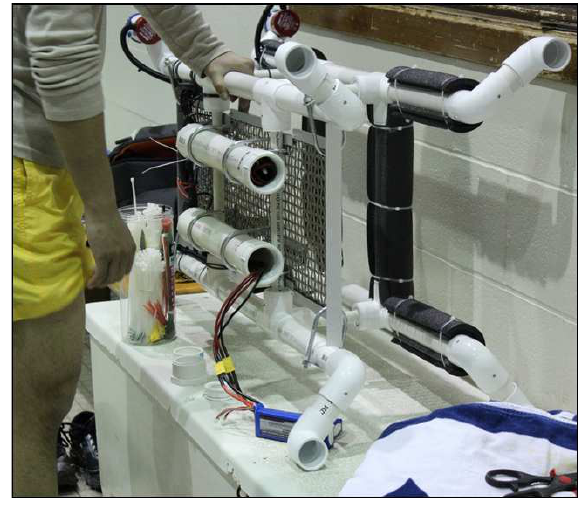
Figure A1. Prototype side view